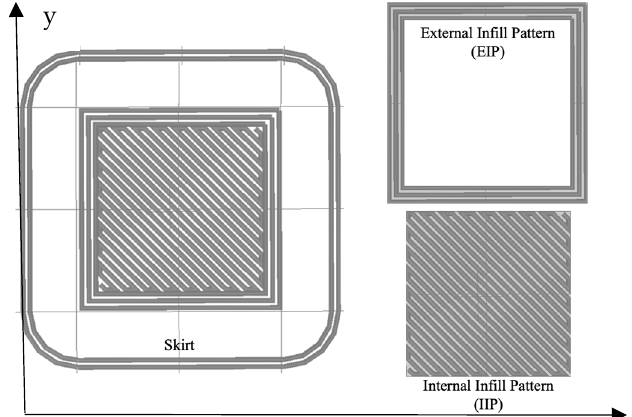
Figure 2. Postprocessed printing part.